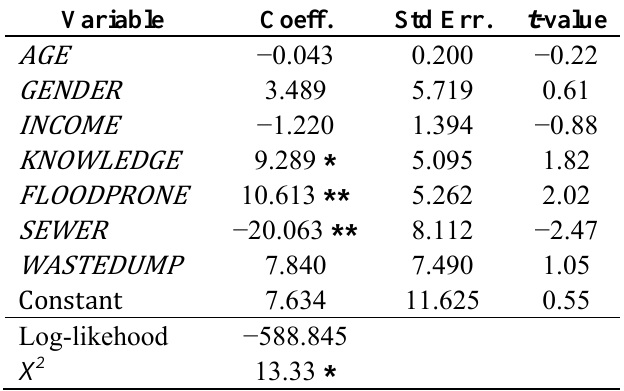
Table 2. Results of Tobit regression analysis of factors affecting WTC L for the prevention of